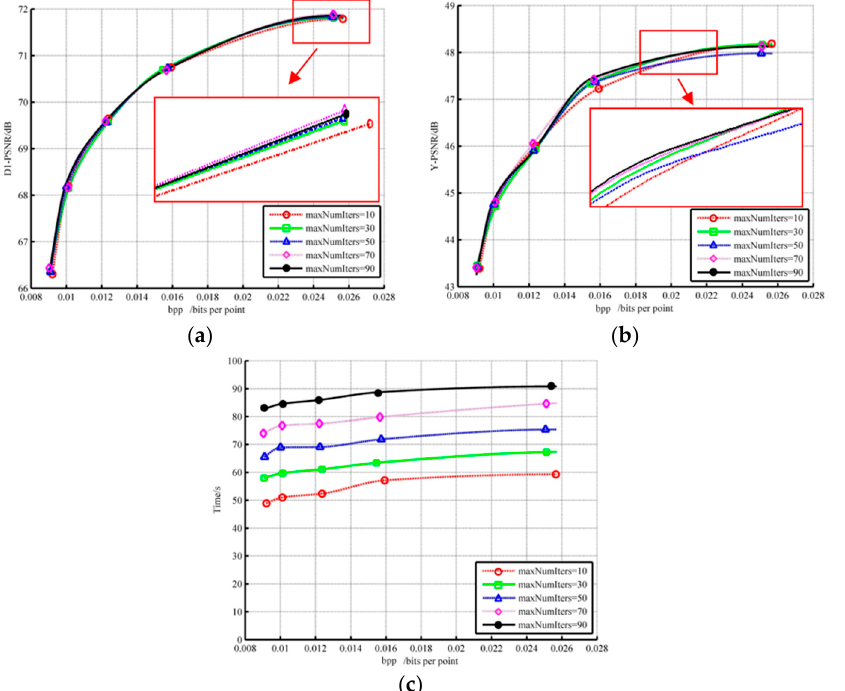
Figure 9. The influence of different numbers of iteration on ( a ) geometry D1 performance; ( b ) color component; ( c ) time.